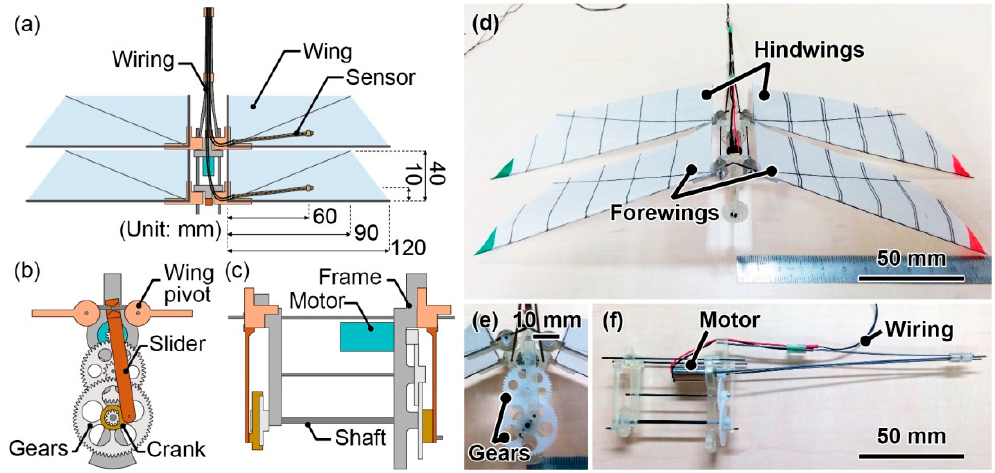
Figure 1. ( a ) Design of the dragonfly-type ornithopter with the MEMS differential pressure sensors on two wings; Mechanism of the wing flap using a motor—front ( b ) and side views ( c ). Changing the attachment point of the slider to the crank varied the phase angle. Photographs of the fabricated ornithopter prototype ( d – f ). Table 1. Characteristics of two dragonfly species [2,4] and the ornithopter prototype. A large variety of properties exist for real dragonflies; the two cited here are examples.